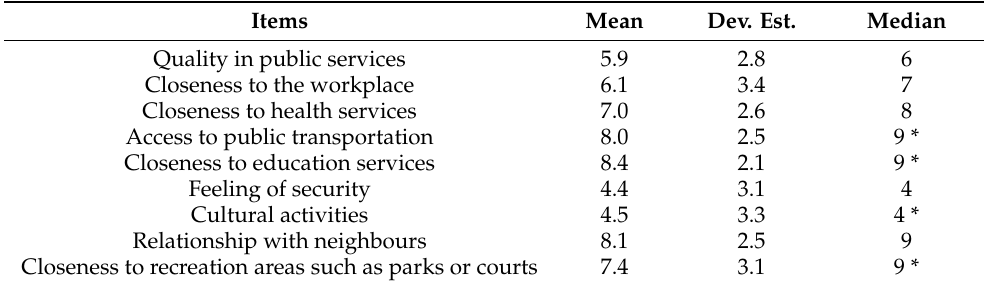
Table 2. Aspects related to the quality of